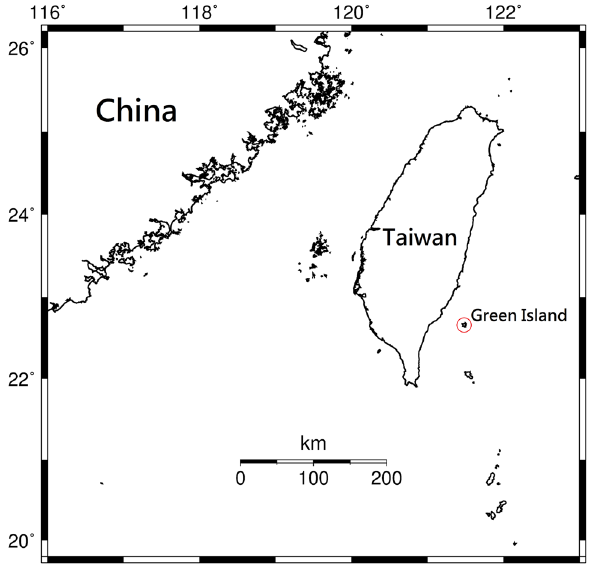
Figure 7. The study site, Green Island, in this research. The figure was created by Generic Mapping Tools (GMT version 5.4.2) 34